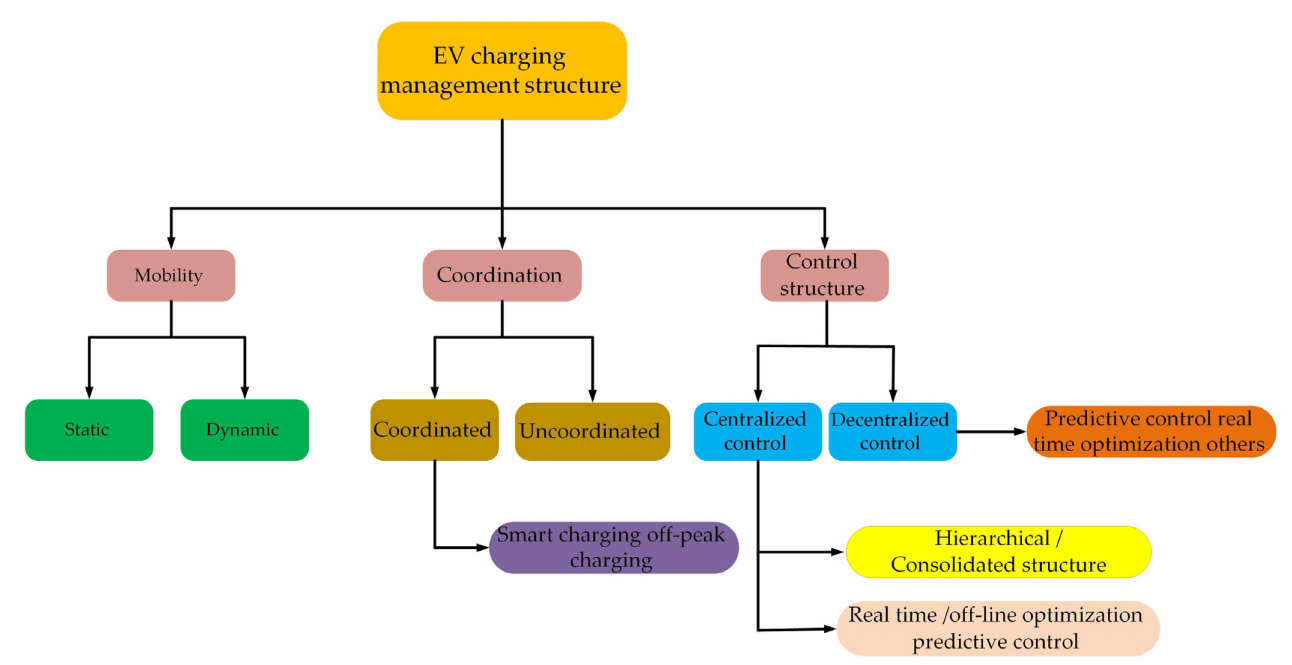
Figure 12. Classification of different control strategies related to EV charging